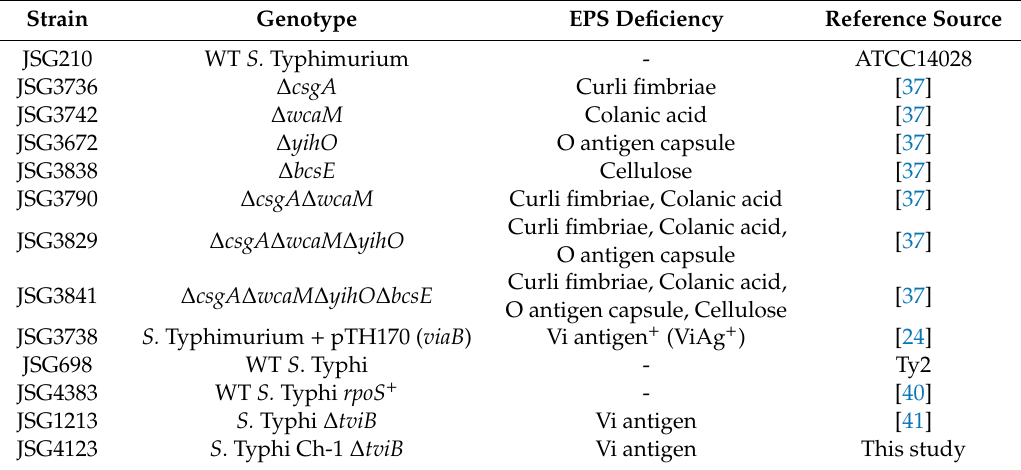
Table 1. Strains used in this study. EPS: extracellular polymeric substances.